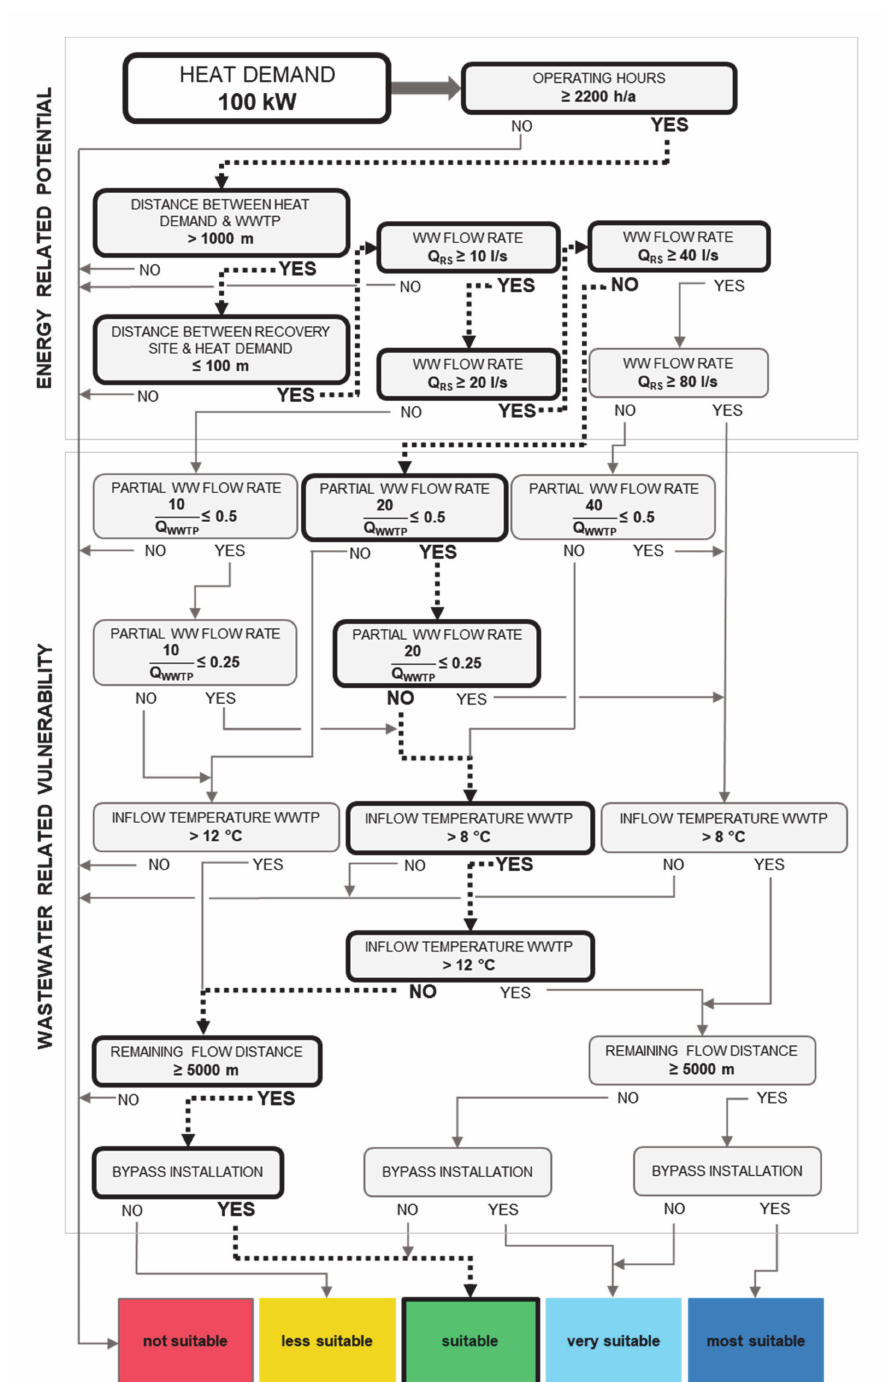
Figure 9. Pre-assessment process for heat recovery site M2 for an intended heat supply of 100 kW (own representation, based on